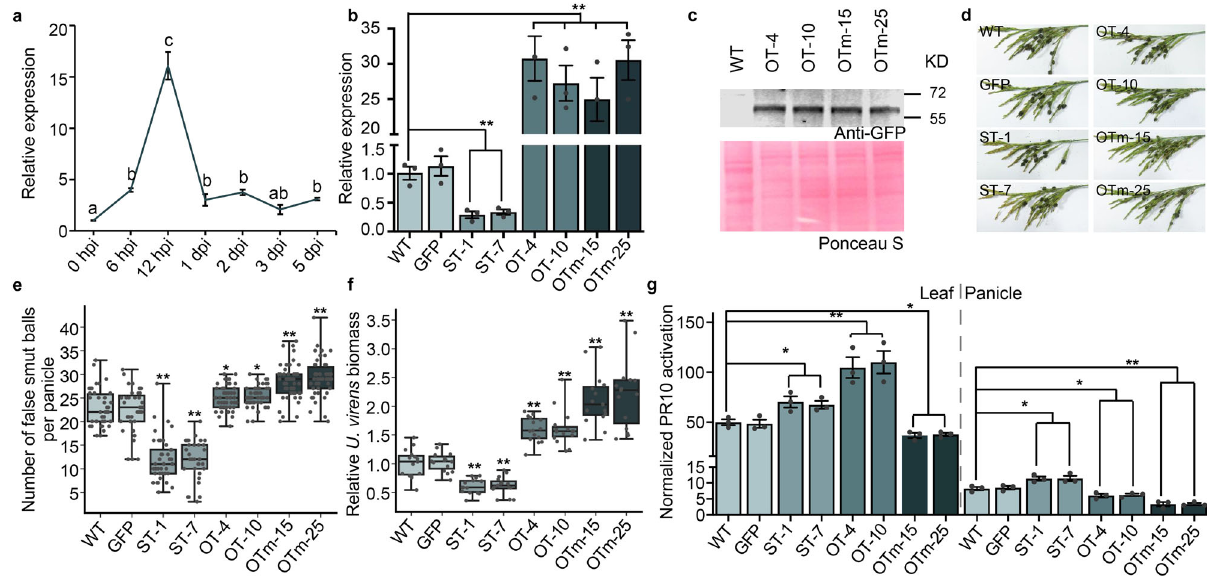
Fig. 8 Involvement in pathogenicity and elicitor function of SGP1 during U. virens infection of rice panicles and challenge of rice leaves. a The relative expression of SGP1 during different stages of infection. SGP1 expression was normalized to its expression level prior to inoculation (0 hpi) using Tubulin as an internal reference. hpi, hours post inoculation; dpi, days post inoculation. Values are the means ± SEM of three biological replicates. The different letters indicate statistically signi fi cant differences ( P < 0.05) as measured by Duncan ’ s multiple range test. b Relative transcript levels of SGP1 in different U. virens transgenic lines. The transcript levels were measured by qRT-PCR and normalized to those in the WT strain using Tubulin as an internal reference. ST, SGP1- silenced transformants of U. virens ; OT, SGP1 overexpression transformants of U. virens ; OTm, SGP1 W44A overexpression transformants of U. virens . Values are the means ± SEM of three biological replicates. (** P < 0.01; two-sided t -test). c Western blot analysis of SGP1 and SGP1 W44A in U. virens WT and transgenic lines with anti-GFP antibody. d – f Pathogenicity phenotypes of transgenic U. virens lines and WT. In box plots, whiskers indicate minimum and maximum values, line indicates the median, the box boundaries indicate the upper (25th percentile) and lower (75th percentile) quartiles. d Representative photographs of disease symptoms on rice panicles. e Quanti fi cation of the number of false smut balls per panicle. Data were collected from fi ve independent experiments, with a total of at least 31 panicles per line. (* P < 0.05; ** P < 0.01 compared with WT, two-sided Dunnett ’ s test). f Relative U. virens biomass in infected spikelets, measured by qPCR of genomic DNA and normalized to WT. Values from fi ve biological replicates were shown, which include three technical replicates for each biological replicate. (** P < 0.01 compared with WT, two-sided Dunnett ’ s test). g Relative induction of PR10 transcription in rice leaves and panicles at 12 hpi. The induction of PR10 expression in U. virens -inoculated rice was normalized to that in mock-inoculated rice, with Actin serving as an internal reference. Values are the means ± SEM of three biological replicates. (** P < 0.01; * P < 0.05; two-sided t